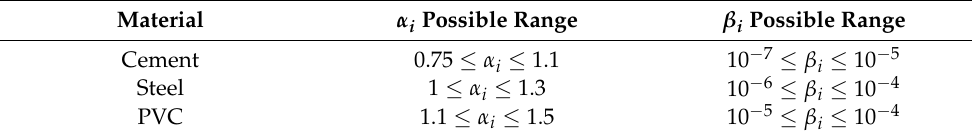
Figure 4. Tank head and pump flows for the dummy field data. Table 1. Chosen α i and β i ranges.